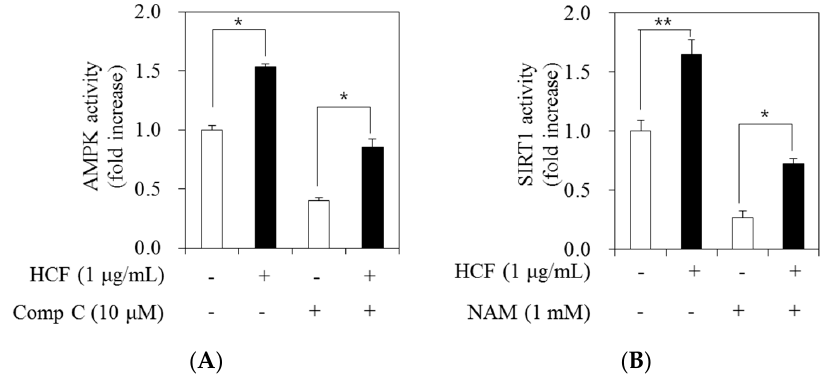
Figure 6. Effects of HCF on activities of AMPK and SIRT1 in 3T3-L1 cells. ( A ) The 3T3-L1 cells were treated with 0 ((MDI—treated control)) or 1 µg/mL HCF for 7 days, then incubated with 10 µM of Compound C (Comp C) as an AMPK inhibitor for 24 h. AMPK activity was determined using an AMPK kinase assay kit. ( B ) The 3T3-L1 cells were treated with 0 ((MDI—treated control)) or 1 µg/mL HCF for 7 days, and incubated with 1 mM nicotinamide (NAM) as a SIRT1 inhibitor for 24 h. SIRT1 activity was measured using a fluoromeric SIRT1 activity assay kit. HCF, hot water extract of C. morifolium flower; AMPK, AMP-activated protein kinase; SIRT1, sirtuin 1. Values are expressed as mean ± standard error of three independent experiments. * p < 0.05 and ** p < 0.01 vs. untreated control.